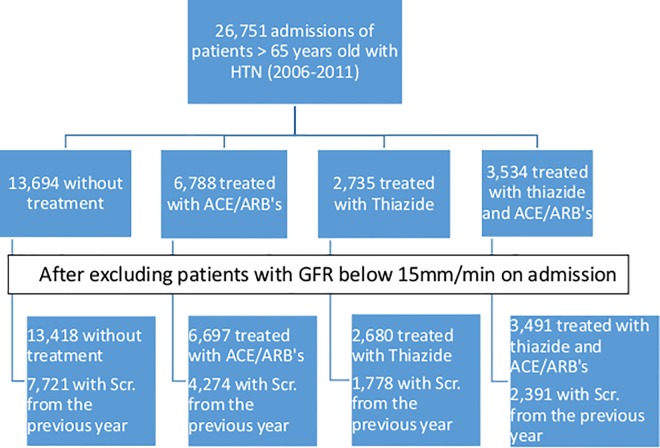
Study flow chart of four medication groups.